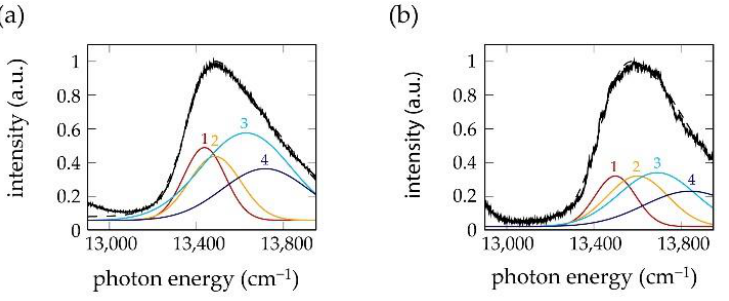
Figure 4. ( a , b ) Decomposition of the polarization-resolved fluorescence-excitation spectra from Figure 3 into four Gaussians 1 to 4 shown in yellow, red, cyan and dark blue, together with the spectrum averaged over all polarizations (black). The data have been taken from [43].